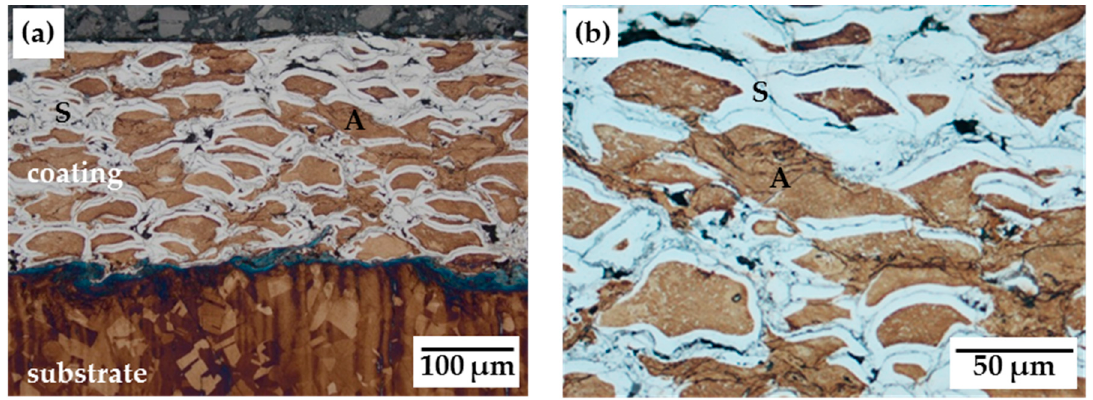
Figure 2. Cross-sectional micrographs of AISI 316L HVOF coating after gas nitriding at 420 °C/10 h with PM + C: ( a ) overview; ( b ) detailed view of the coating. (S: S-phase, A: austenitic phase.)